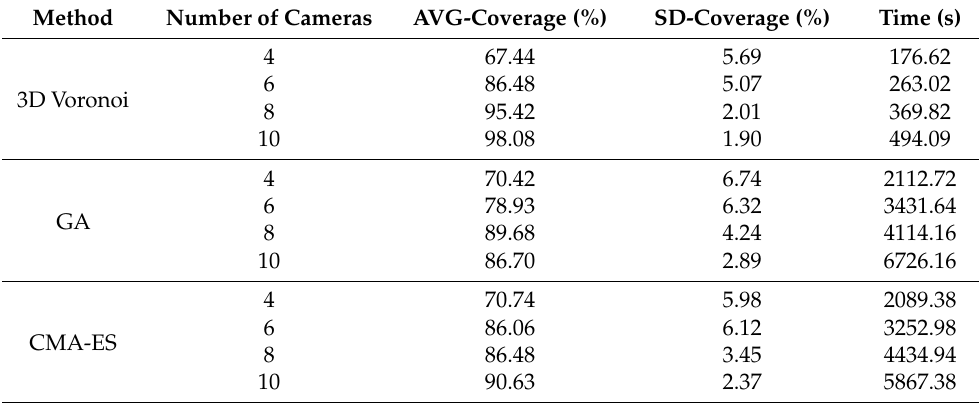
Table 3. Results of 3D Voronoi, GA, and CMA-ES algorithms for different numbers of cameras with 30 m sensing